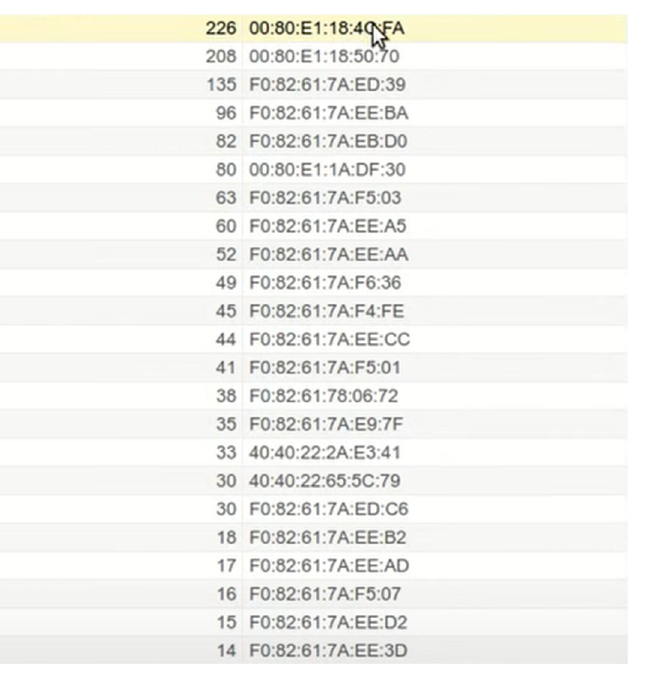
Figure 16. Switches sorted by number of unregistrations in a given period of time.